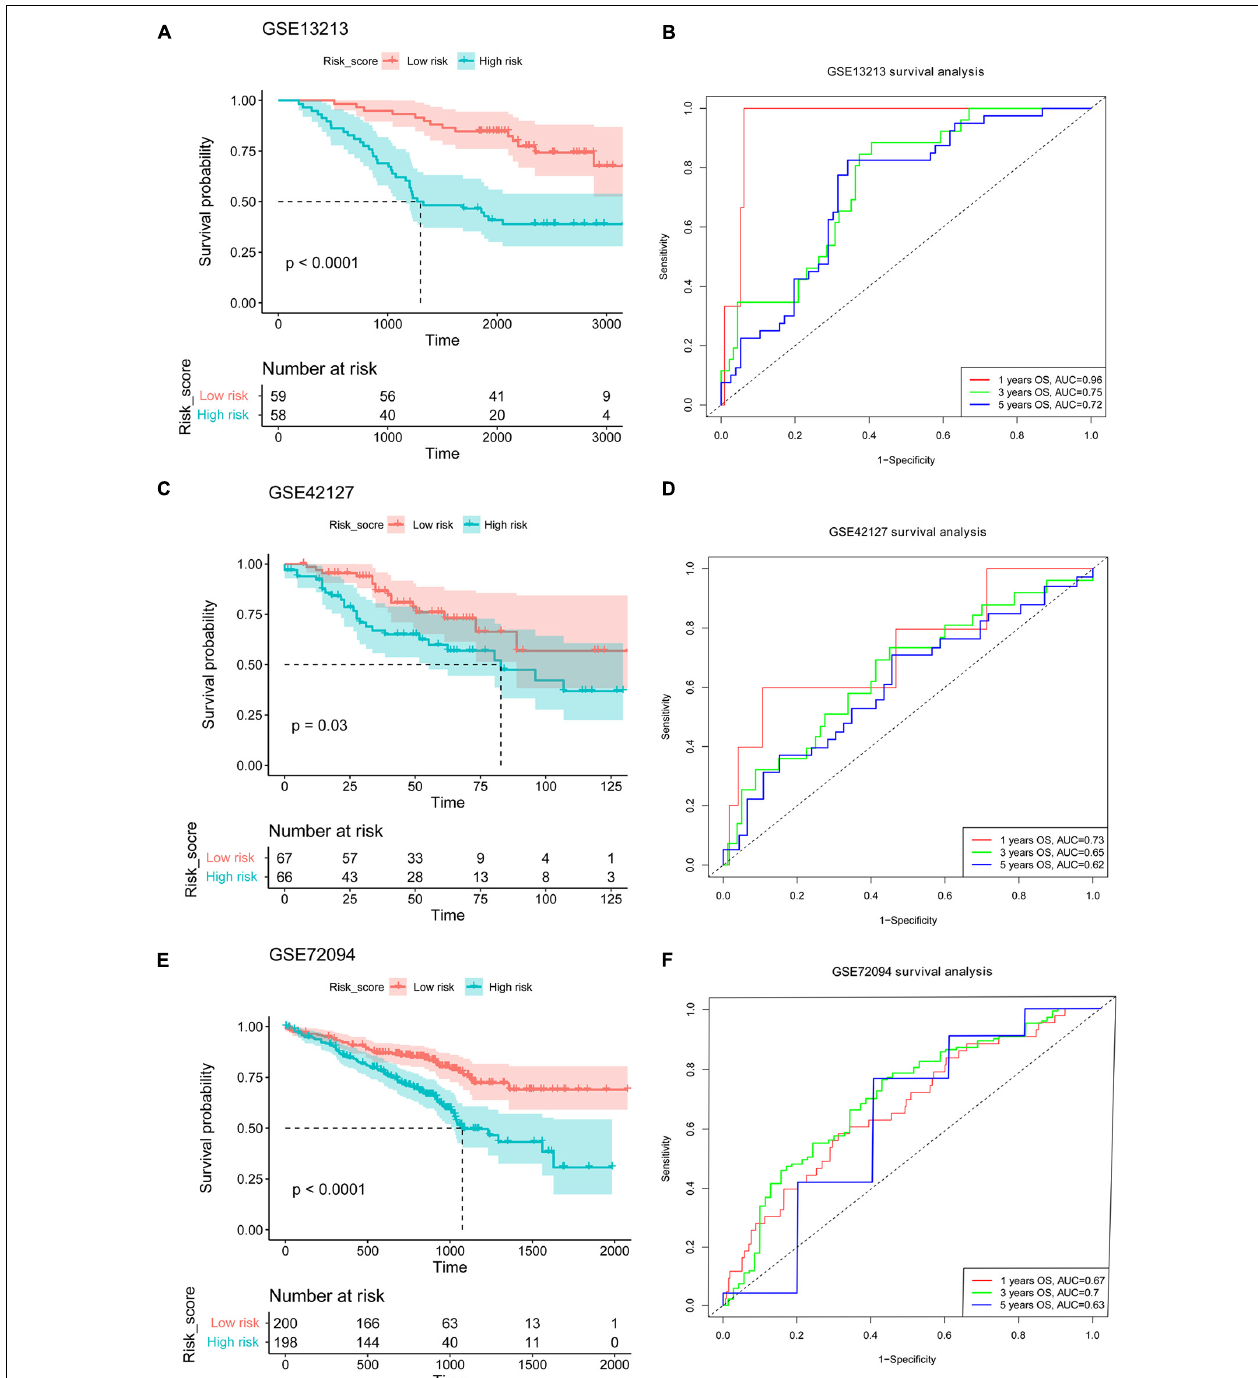
FIGURE 3 | Validation of the established NMGs signature. Kaplan-Meier OS curves for patients assigned to high- and low-risk groups based on the risk score in the GSE13213 (A) , GSE42127 (C) , and GSE72094 (E) cohort. The ROC curves of 1-, 3-, and 5-year OS in the GSE13213 (B) , GSE42127 (D) , and GSE72094 (F) cohort. NMGs: nuclear mitochondrial genes; OS: overall survival; ROC: receiver operating characteristic.